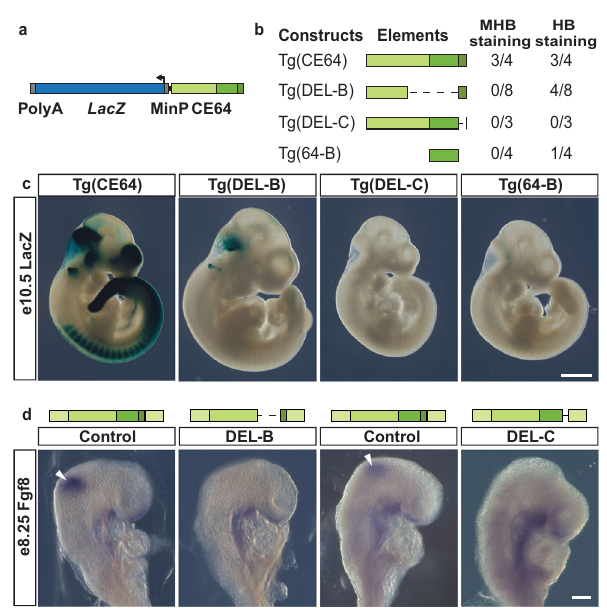
Fig. 5 The function of 64-B and 64-C is interdependent. a Schematic of transgenic reporter construct containing LacZ , a minimal promoter and the putative enhancer sequence of interest. b Table of constructs used for transgenesis, the CE64 subunits included and the number of embryos displaying reporter expression for each construct (i.e. 3/4 means that out of a total of 4 transgenic embryos, 3 display positive reporter expression). c Photomicrographs of representative embryos stained for LacZ activity. Reporter expression in the MHB is only detected in wt Tg(CE64) embryos. Note the staining that is present in the anterior hindbrain of some of the Tg (DEL-B) embryos. Tg(DEL-C) and Tg(64-B) do not manifest any reproducible reporter expression. d In situ hybridization of control, DEL-B and DEL-C deletion embryos at e8.25 with riboprobe against Fgf8 . Expression is undetectable in both enhancer subunit deletions ( n = 4). Blue box indicates LacZ reporter gene in ( a ). In all panels, light green, green and dark green boxes indicate 64-A, 64-B, and 64-C subunits, respectively. Scale bar is 1 mm in ( c ) and 100 μ m in ( d